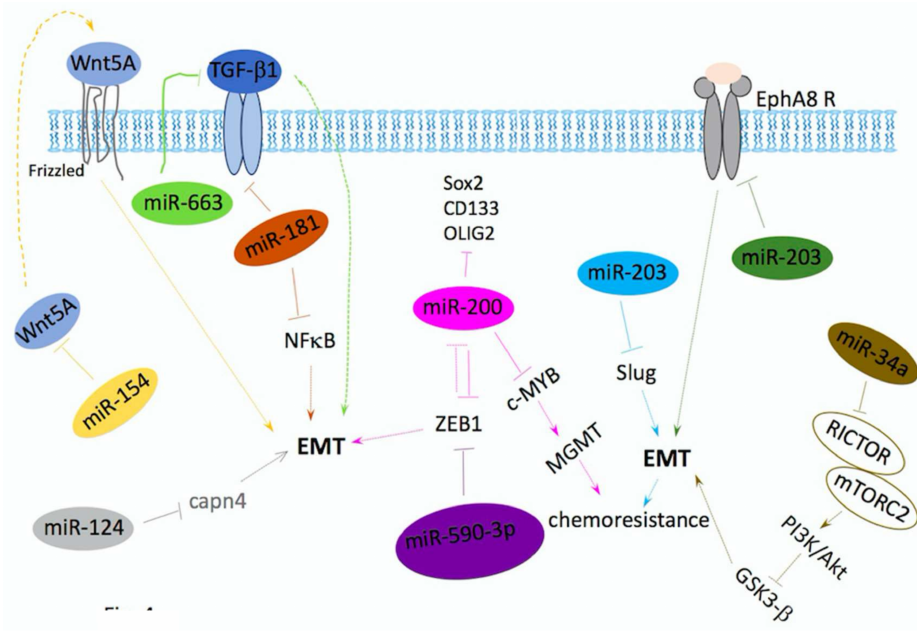
Figure 4. miRNAs regulate GBM invasion and progression through EMT. Solid arrows, activation; dotted arrows, putative activation; solid Y bar, inhibition; dotted Y bar, putative